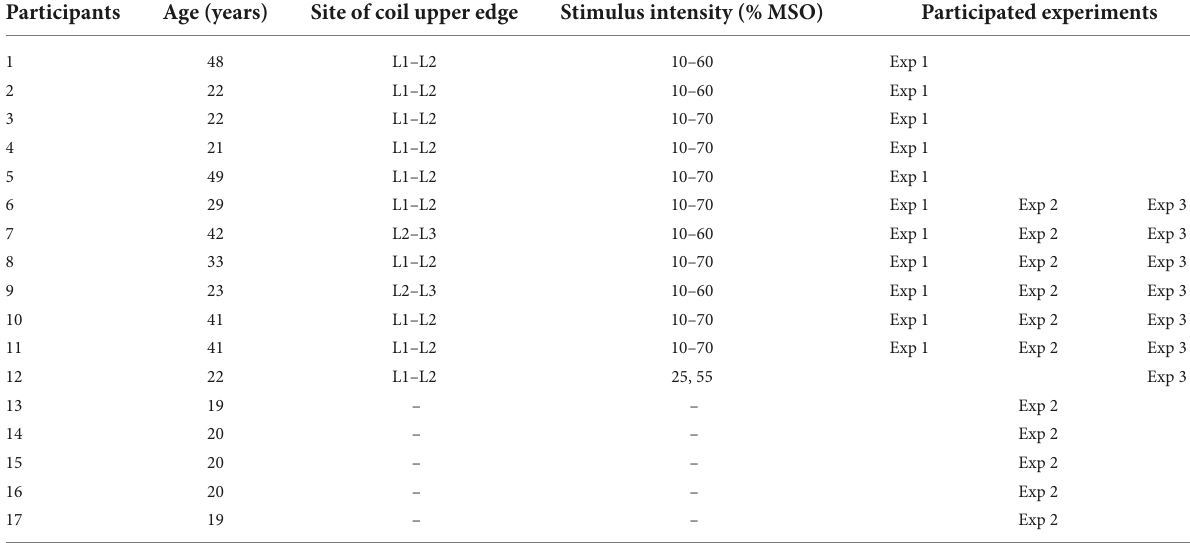
TABLE 1 Participants’ age, stimulus site and intensity, and participated experiments.